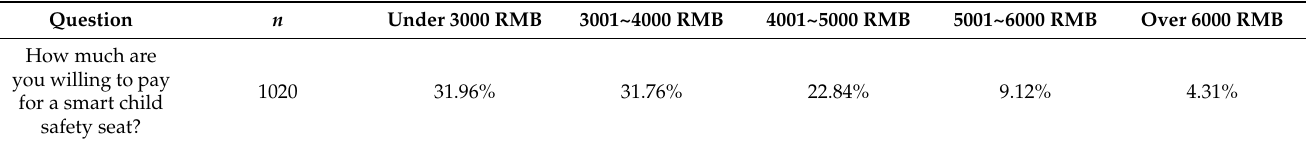
Table 3. The price respondents are willing to pay.